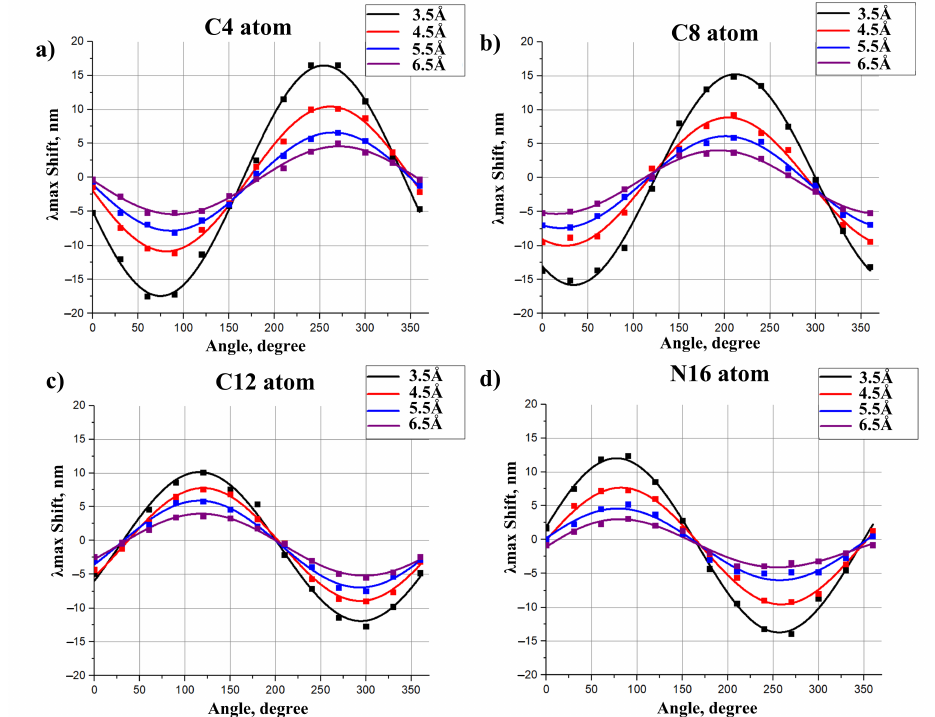
Figure 5. Impact of the dipole moment on λ max of the 11-cis PSB as a function of the angle between the dipole and the chromophore axis. Functions were calculated at different positions of the dipole relative to the chromophore. Dipoles were located at the distances 3.5 Å, 4.5 Å, 5.5 Å, 6.5 Å from the C 4 ( a ), C 8 ( b ), C 12 ( c ), and N 16 ( d ) chromophore atoms along the grid line perpendicular to the chromophore axis (see Figure 4). Dots represent the ab initio calculated values. Functions were derived as the spline interpolation of the calculated